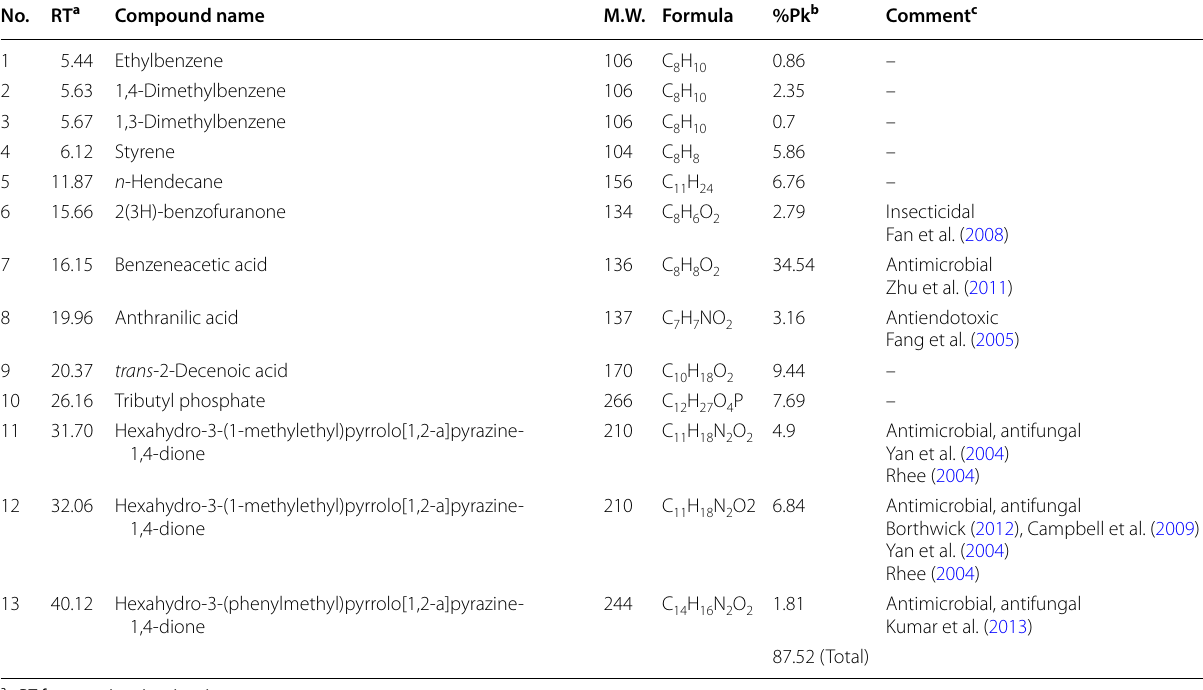
Table 1 Compounds derived from supernatant of Alcaligenes sp. CT10